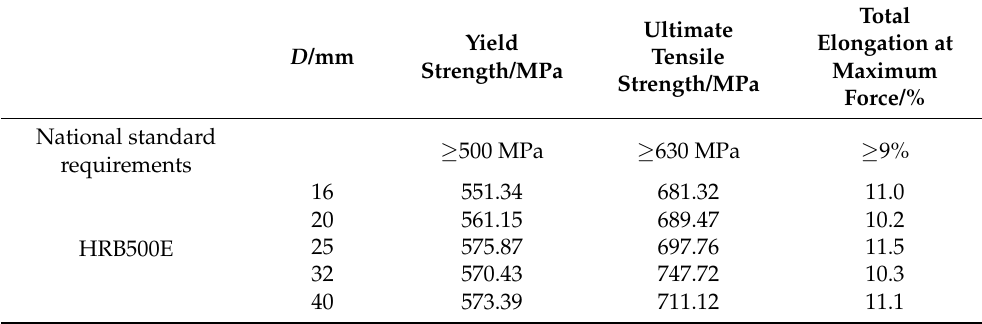
Table 2. Quasi static measured mechanical property indexes of